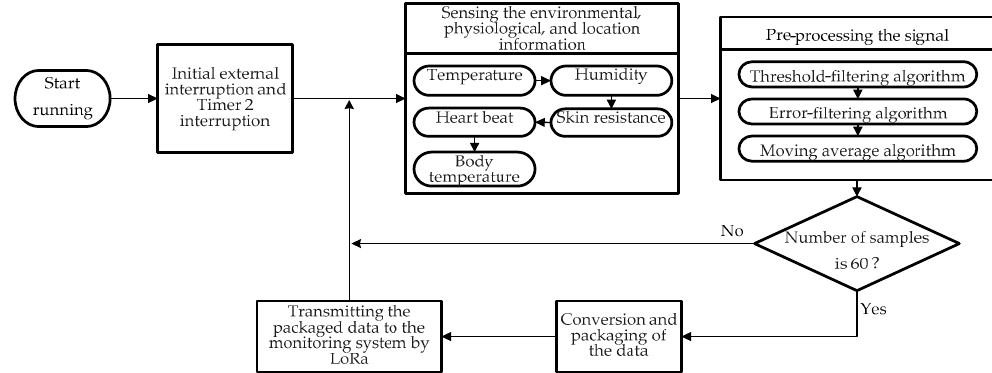
Figure 5. Workflow for extracting information on the surrounding environment and the user’s